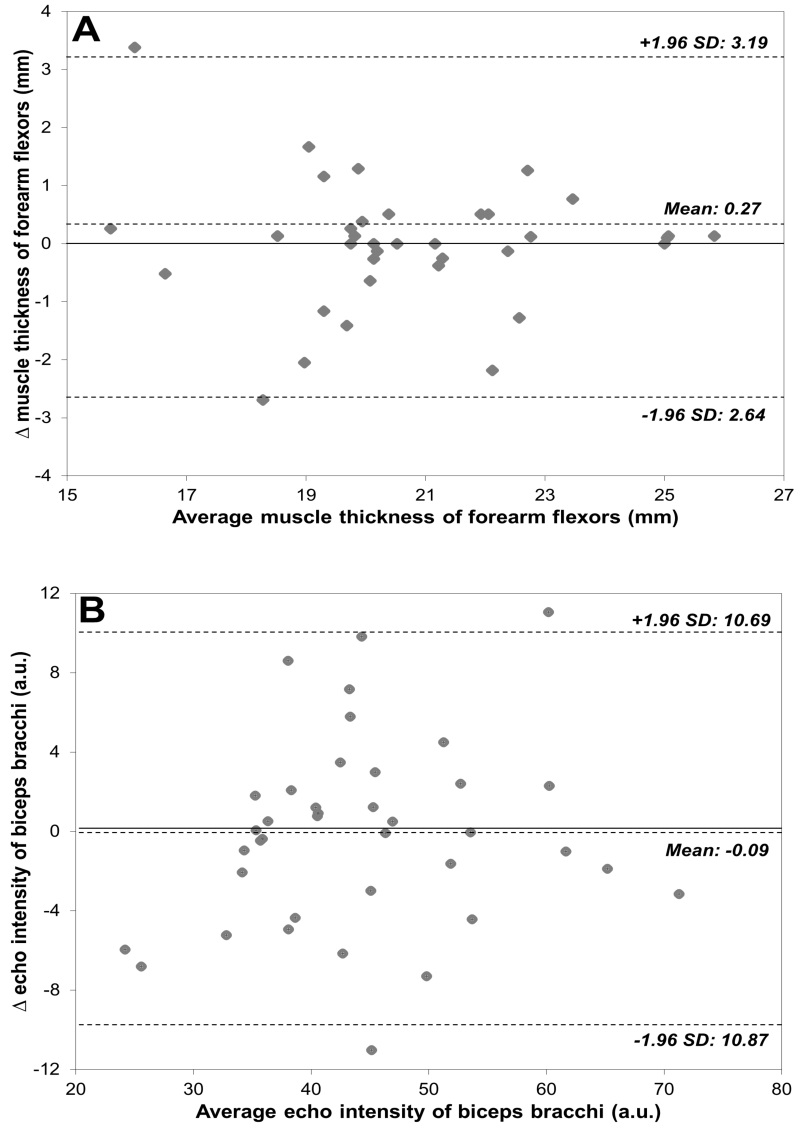
Bland-Altman plots illustrating the differences between evaluations 1 and 2. (A) Muscle thickness of forearm flexors; (B) echo intensity of biceps brachii. The bias line and random error lines forming the 95% limits of agreement are presented by dashed lines. SD: standard deviation.